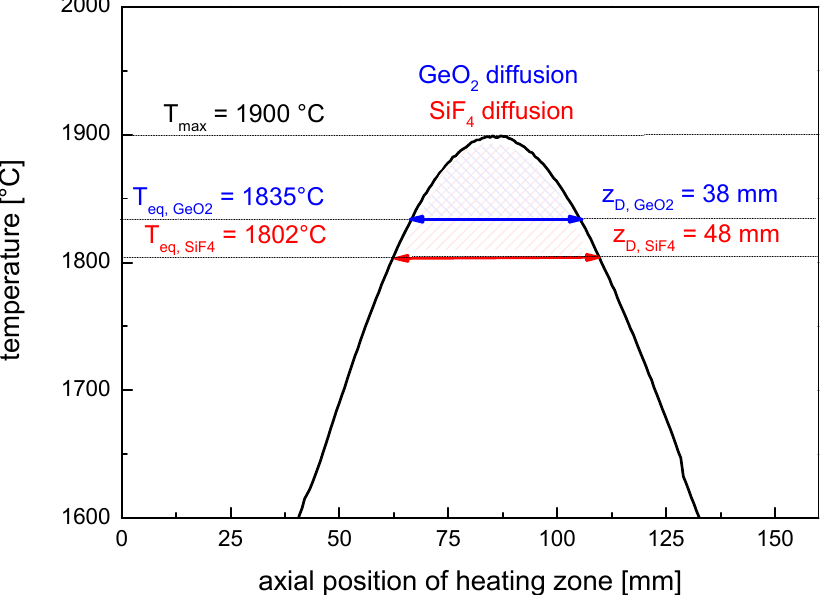
Figure 2. Axial temperature profile of drawing furnace as determined from thermocouple measurements with a maximum temperature of 1900 °C. The effective lengths z D for radial diffusion of GeO 2 and fluorine are marked in the curve in blue and red,